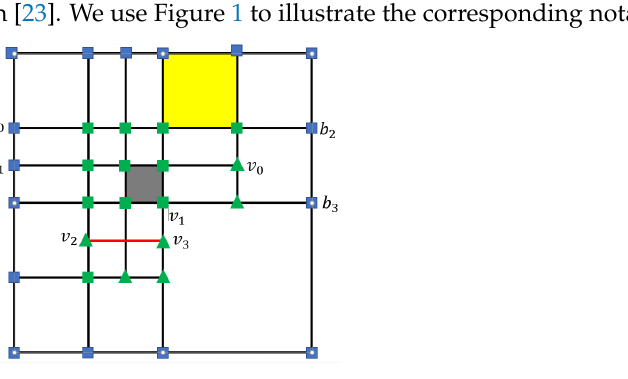
Figure 1. The vertices, edges, and cells on T . The green square vertices denote crossing vertices, the green triangular vertices denote T-junctions.The gray cell denotes an interior cell, the yellow cell denotes a boundary cell.